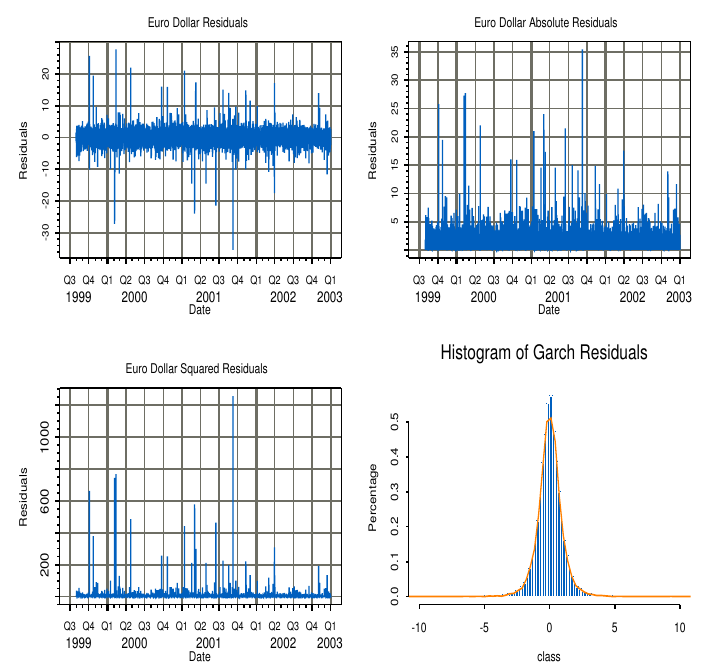
Figure 7. Euro-Dollar residuals, absolute residuals, squared residuals and histogram of the residuals after fitting a GARCH process.